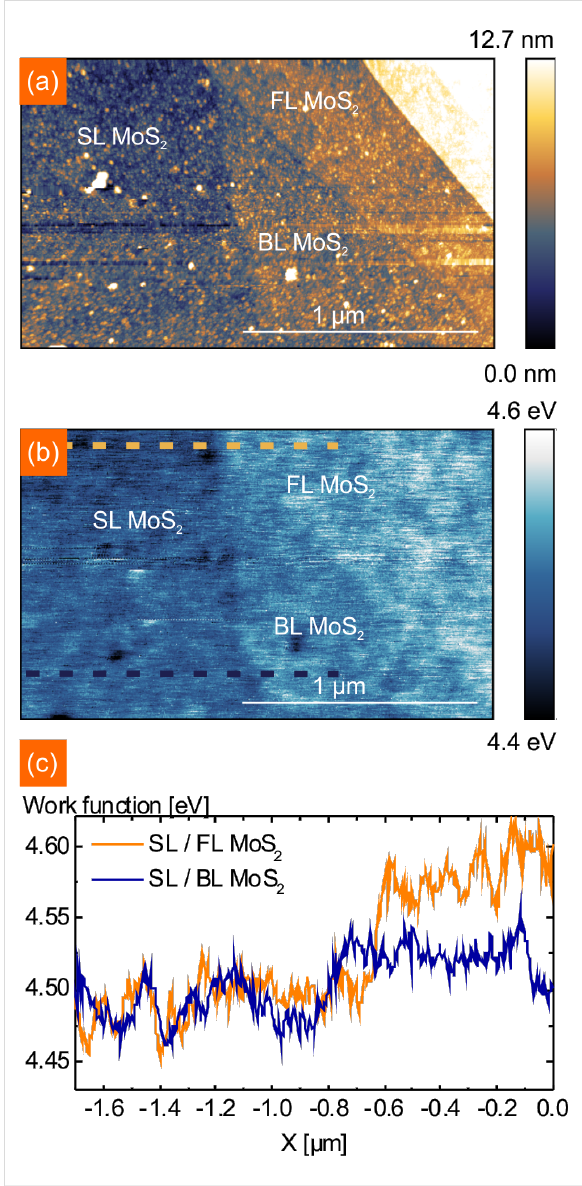
Figure 4: (a) NC-AFM zoom-in of an area consisting of 1L, 2L and FL MoS 2 . (b) Corresponding KPFM image, calibration of the tip on the gold contact allows assignment of work functions to surface potential values. Plotted is the work function. (c) Line profiles of the work func- tion corresponding to the lines marked in (b).